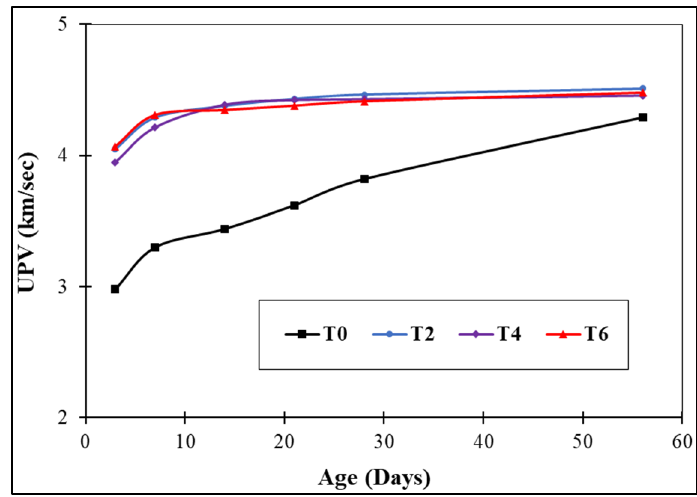
Figure 6. UPV for various mix proportions.